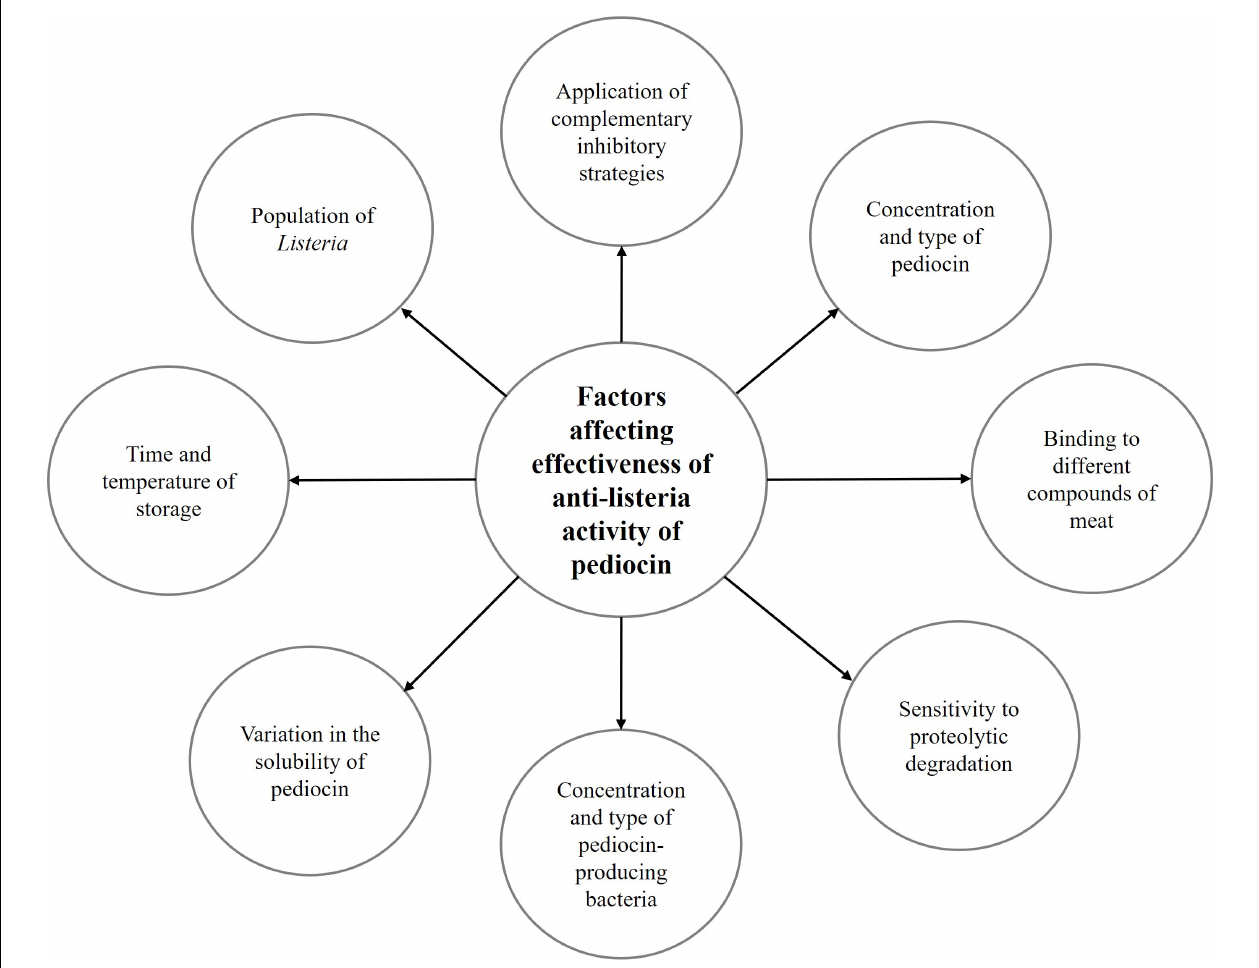
FIGURE 3 | Factors affecting the effectiveness of pediocin in inhibition of Listeria in meat and meat